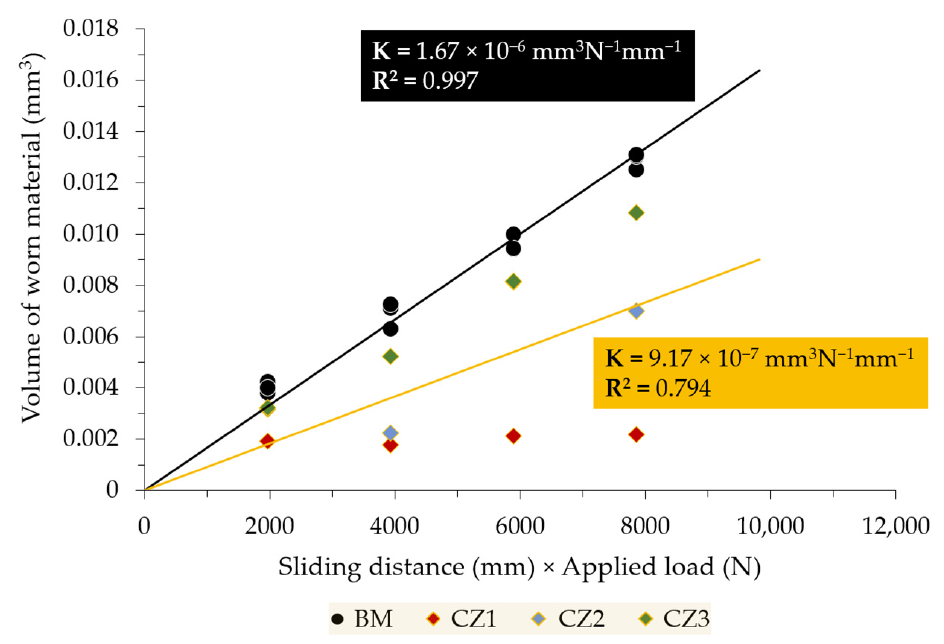
Figure 7. Volume of worn material as a function of the sliding distance under a constant load of 0.25 N for the reinforced zone and the base metal.